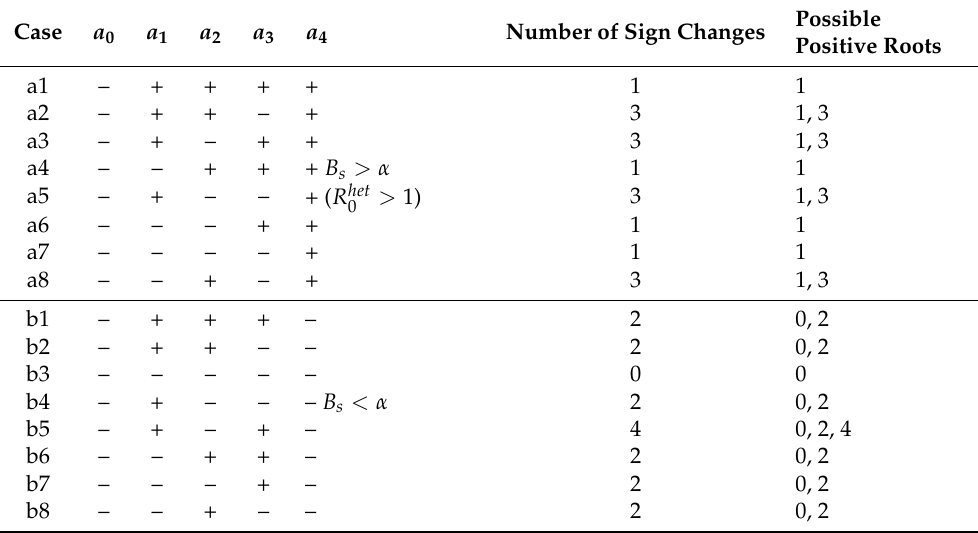
> 1, the existence of EE is always guaranteed. Note that when R het 0 The above table of the number of possible positive roots of p ( I ∗ the following theorem.